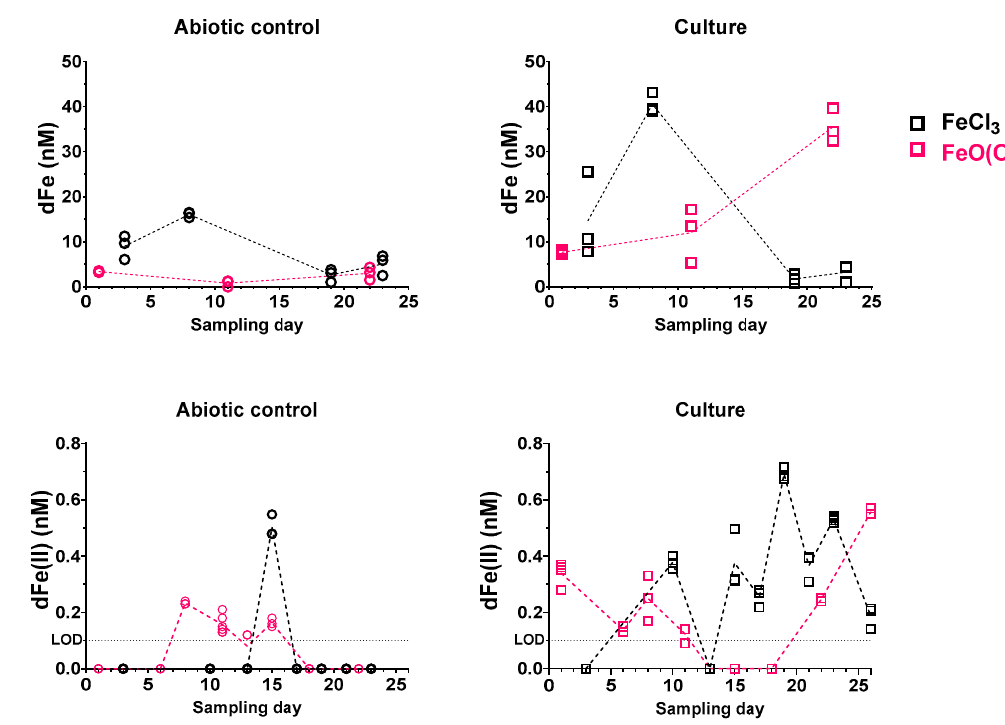
Figure 5. Changes in total dissolved iron concentration (top) and dissolved iron (II) (bottom) for abiotic controls and cultures of Synechococcus grown on FeCl 3 (black) and FeO(OH) (red) in triplicate with trend lines. Limit of detection (LOD) is indicated for total dissolved iron II